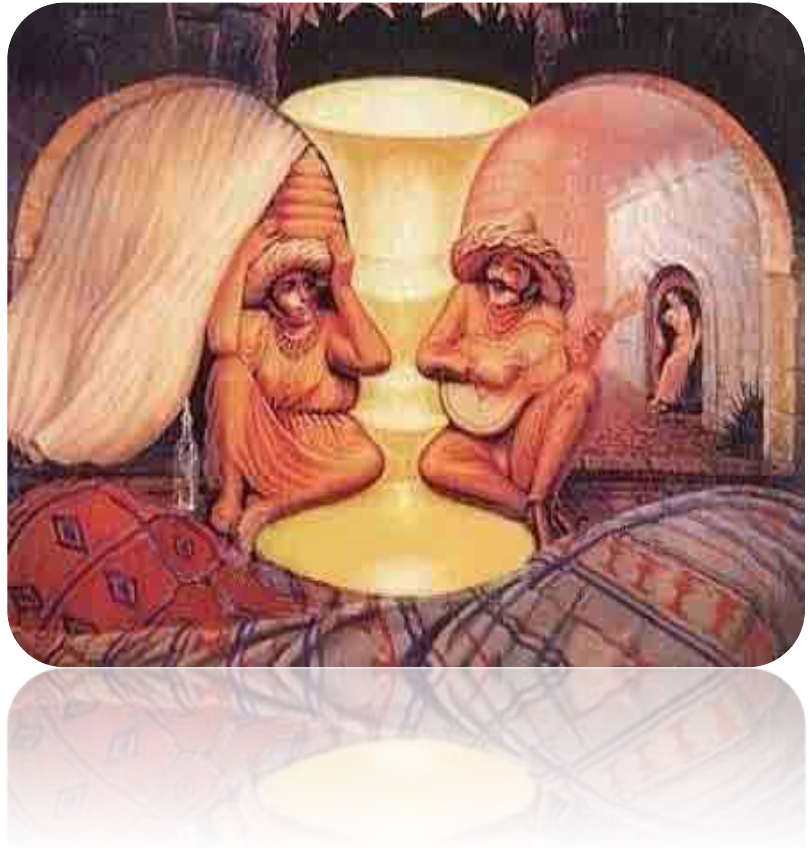
Figure 4. Faces/people, vase, and